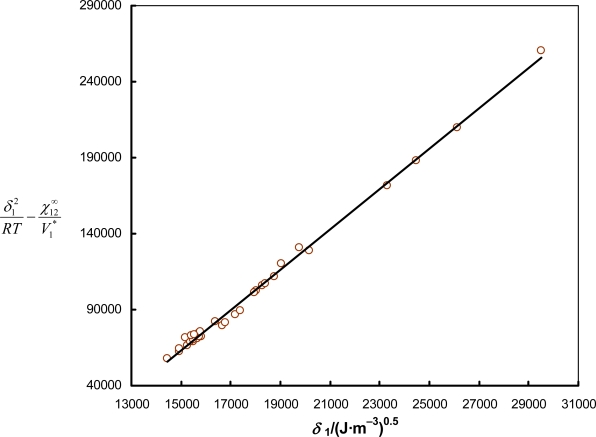
An example of the determination of solubility parameter δ2. Plot of
δ12RT−χ12∞V1* versus δ1 according to the equation 7 for ionic liquid [(C6OC)2im][NTf2] at T = 368.15 K.